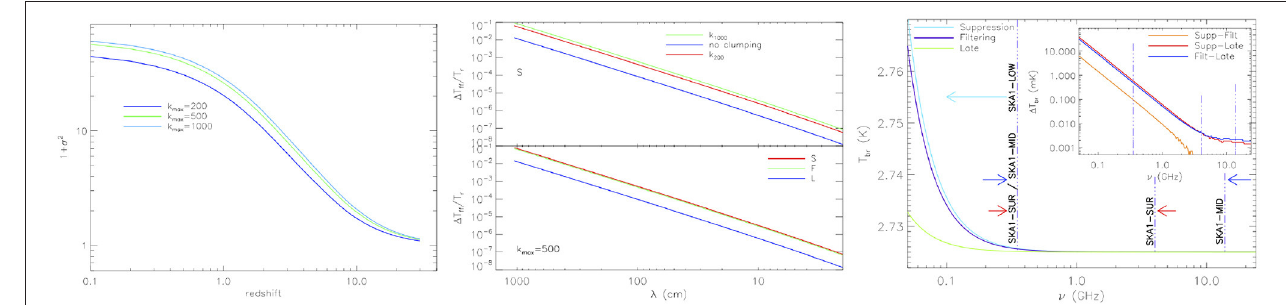
FIGURE 6 | Left : Evolution of clumping factor for three values of k max . Middle : Brightness temperature relative excess predicted at current time “as function of the wavelength assuming the y B ( x ) value properly evaluated at each frequency in the entire range.” The upper panel refers to the suppression model for k max = 200 and 1000 and “without the correction due to the IGM density contrast.” The bottom panel shows a comparison between the three considered reionization histories for k max = 500. Right : “FF distortion in SKA 2 frequency range by two astrophysical reionization histories and a late phenomenological model, displayed for comparison.” The inset shows the absolute differences between these models. The vertical lines illustrate the ranges of SKA 1 configurations. Left and middle panels reprinted from Trombetti (2018), right panel reprinted from Burigana et al.